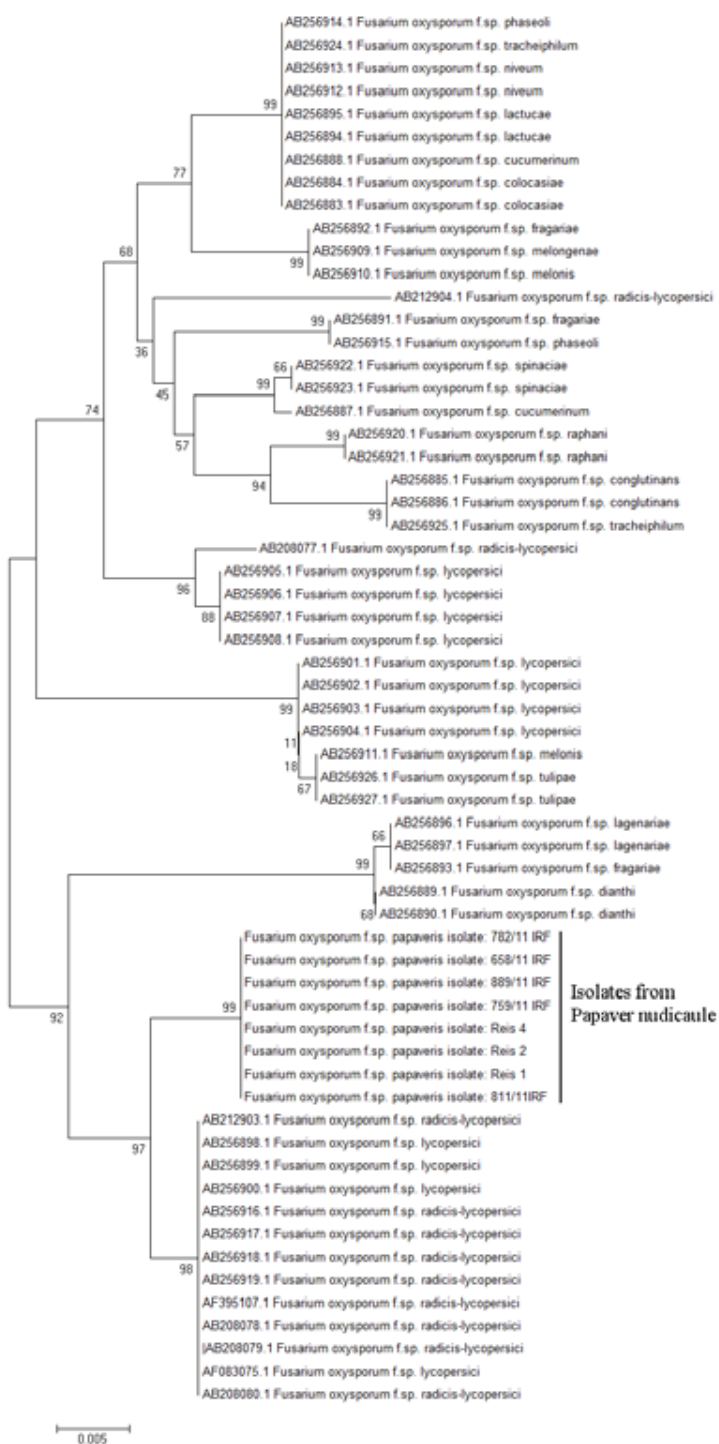
Figure 4. Phylogenetic tree based on Pgx1 gene sequences built by Mega5 software with Neighbor joining method; boot- strap values from 1000 replicates are shown at the